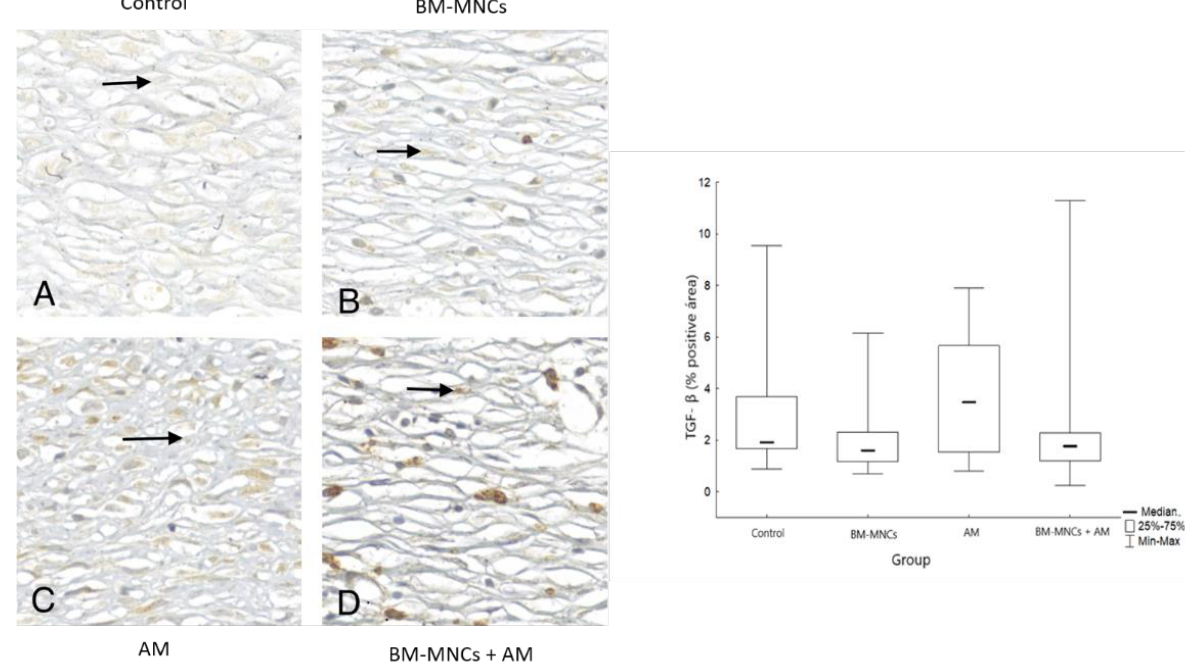
Figure 7. Representative immunohistochemical staining images of the expression of TGF- β showed the lowest percentages in the control ( A ), BMSCs ( B ), AM ( C ) and BMSCs + AM ( D ) groups on the 28th day of the experiments.